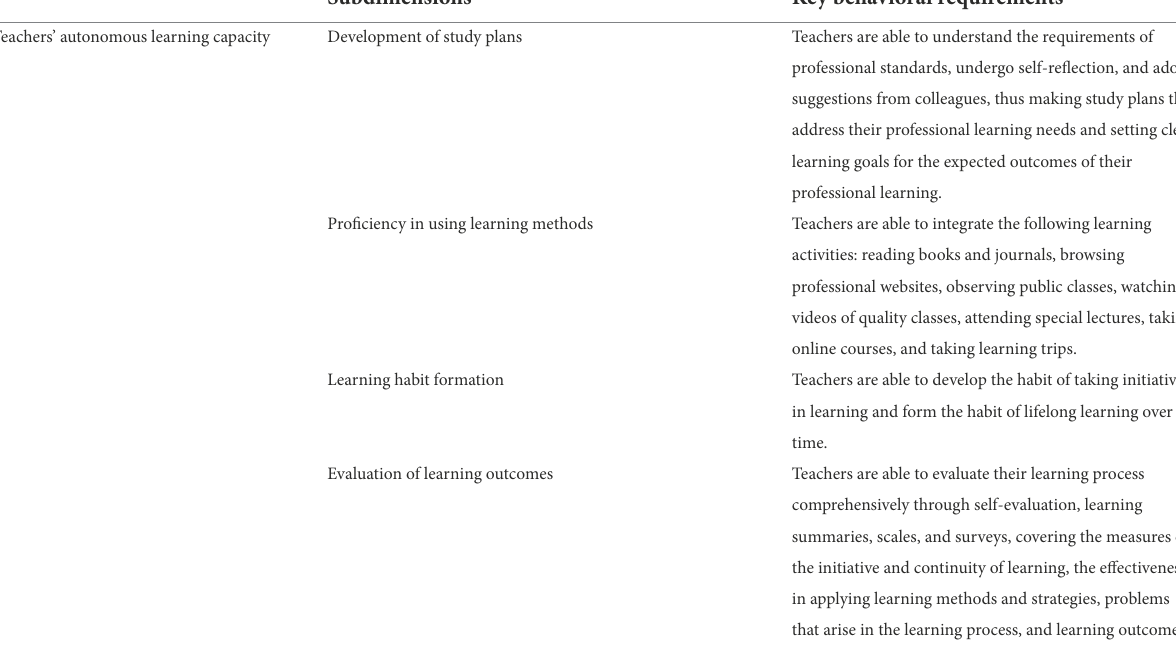
TABLE 1 Subdimensions of teachers’ autonomous learning capacity and behavioral